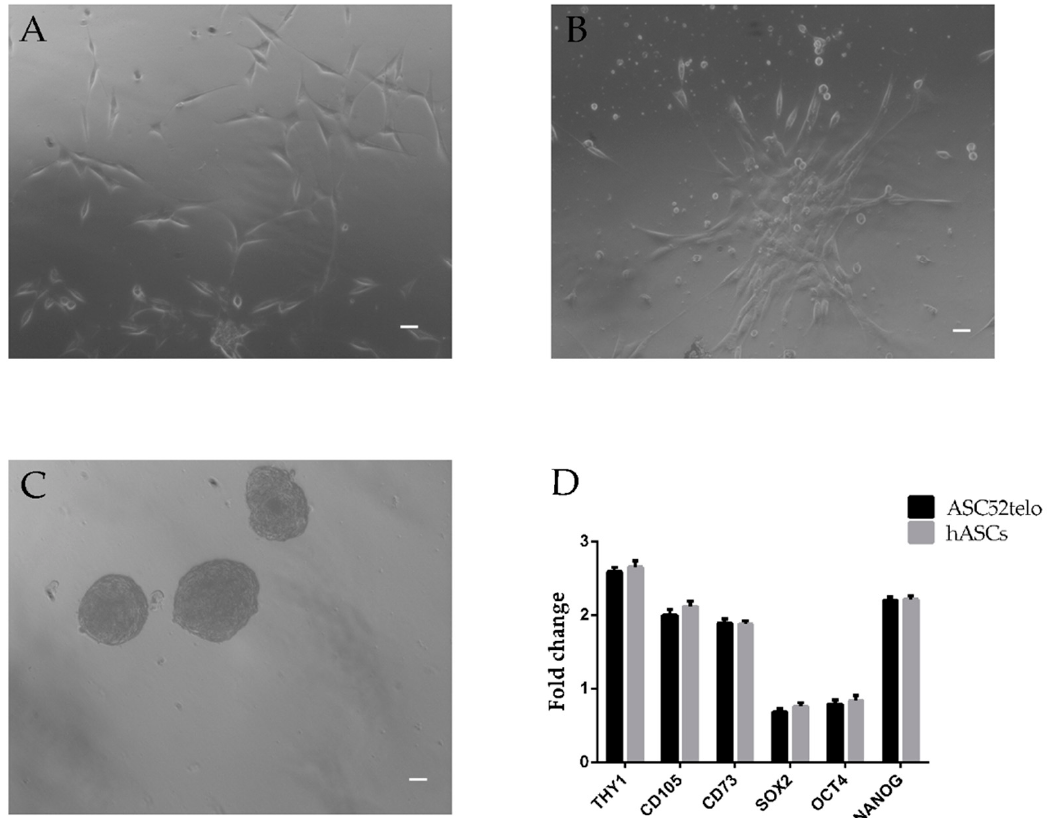
Figure 1. hASC morphology on day 5 ( A ) of expansion culture observed under light microscopy (10 × ) with phase contrast with a Nikon DS-FI1 CCD camera. Scale bar = 10 µ m. ( B ) Shows the formation of hASC colonies when cultured in adhesion, Scale bar = 10 µ m, while ( C ) shows spheres which formed when hASCs were cultured in low adhesion culture conditions, Scale bar = 10 µ m. A representative experiment referring to 23 samples studied. ( D ) qRT-PCR analysis in freshly isolated hASCs at passage 4 of THY1 , CD73 , CD105 , OCT4 , SOX2 and NANOG gene expression compared to ASC52telo, hTERT immortalized adipose-derived mesenchymal stem cells. Data shown are relative to an endogenous control (beta-Actin). Relative expression levels were assessed using the 2 − ∆∆ C t method. Values are shown as the mean ± SE. Data are representative of three independent experiments.